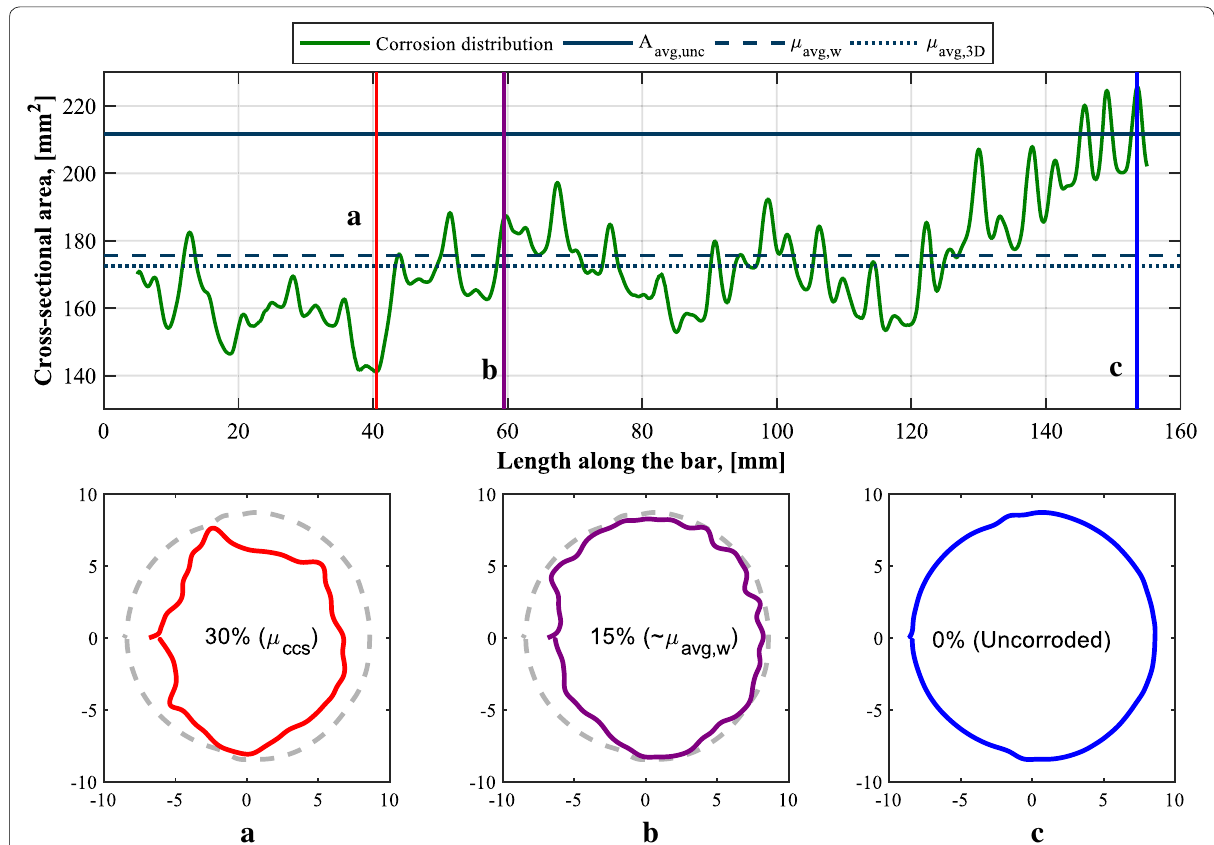
Fig. 4 Corrosion measurement by means of 3D-scanning. a , b and c corresponds to critical corroded cross-section, average corroded cross-section and uncorded cross-section